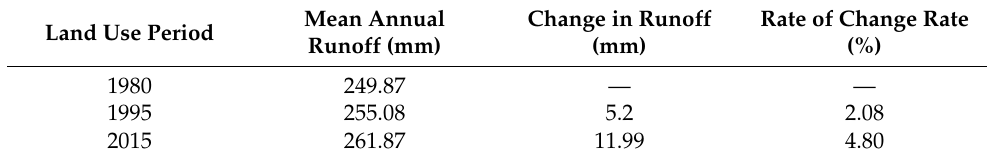
Table 5. Variation of simulated runoff for different years.